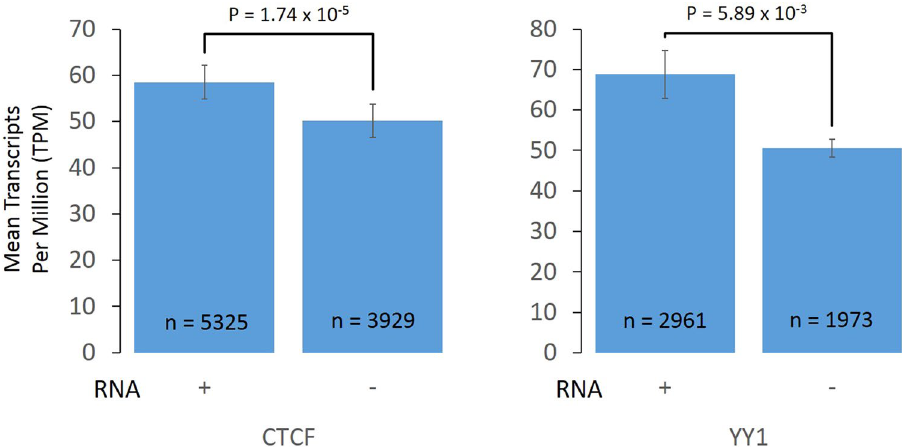
Figure 2. Average expression levels (mean Transcript Per Million [TPM]) of genes interacting with two categories of promoter interacting regions (PIRs): RNA-PIRs with CTCF or YY1 binding sites, and nonRNA- PIRs with CTCF or YY1 binding sites. Pairwise p-values were obtained from Mann–Whitney